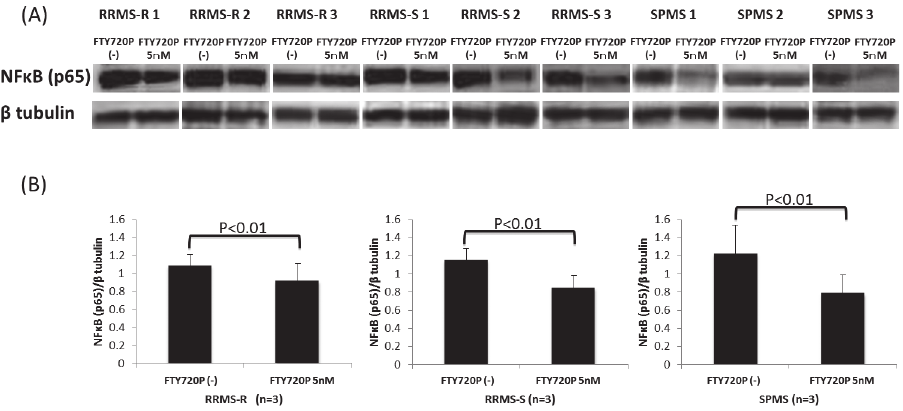
Fig 3. The effects of pretreatment with fingolimod-phosphate on NF κ B in the presence of MS sera. (A) The effects of pretreatment with fingolimod-phosphate on the p65 subunit of NF κ B in the human brain microvascular endothelial cells in the presence of MS sera were determined using a Western blot analysis. (B) Each bar graph reflects the combined densitometry data for the independent experiments (mean ± SEM, RRMS-R n = 3, RRMS-S n = 3, SPMS n = 3). Pretreatment with fingolimod-phosphate significantly decreased the protein levels of the p65 subunit of NF κ B in the BMECs compared with that observed in the cells not pretreated with